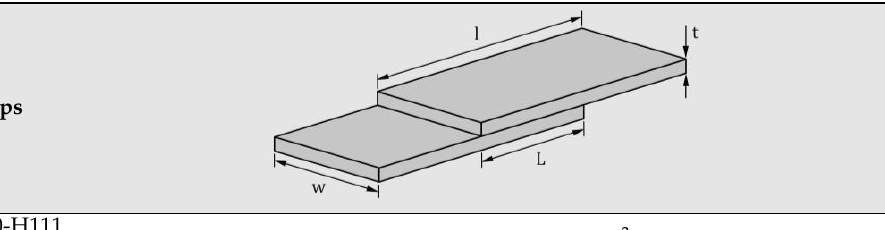
Table 1. Geometry and process parameters of the unit cells corresponding to the injection lap riveted and bolted joints.